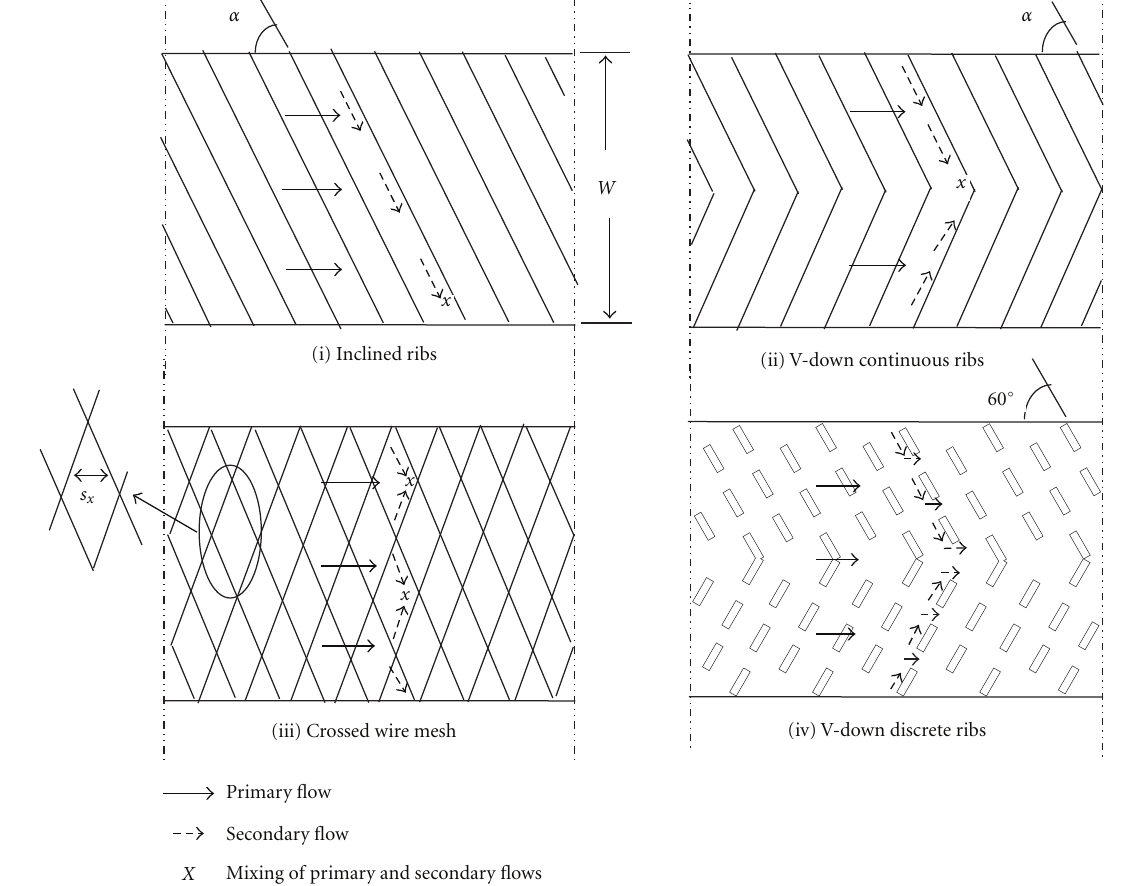
F 2: Effect of rib orientation on the �ow